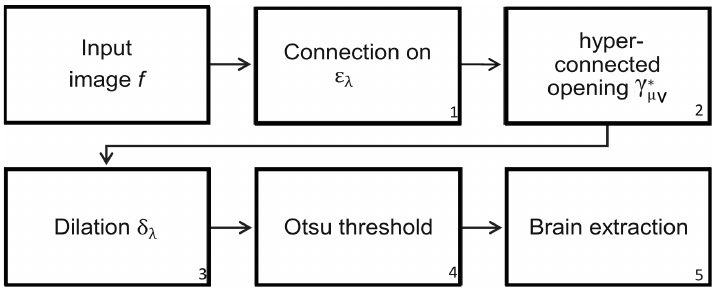
Figure 9. Steps to segment the brain using the Hyperconnected Lower Leveling (HLL) procedure. Table 2. Jaccard and Dice indices computed for 38 volumes of MRI obtained from the IBSR repository. The brain segmentation in this work utilized the steps provided in Figure 9, and the computed indices are in columns HLL Jaccard and HHL Dice.